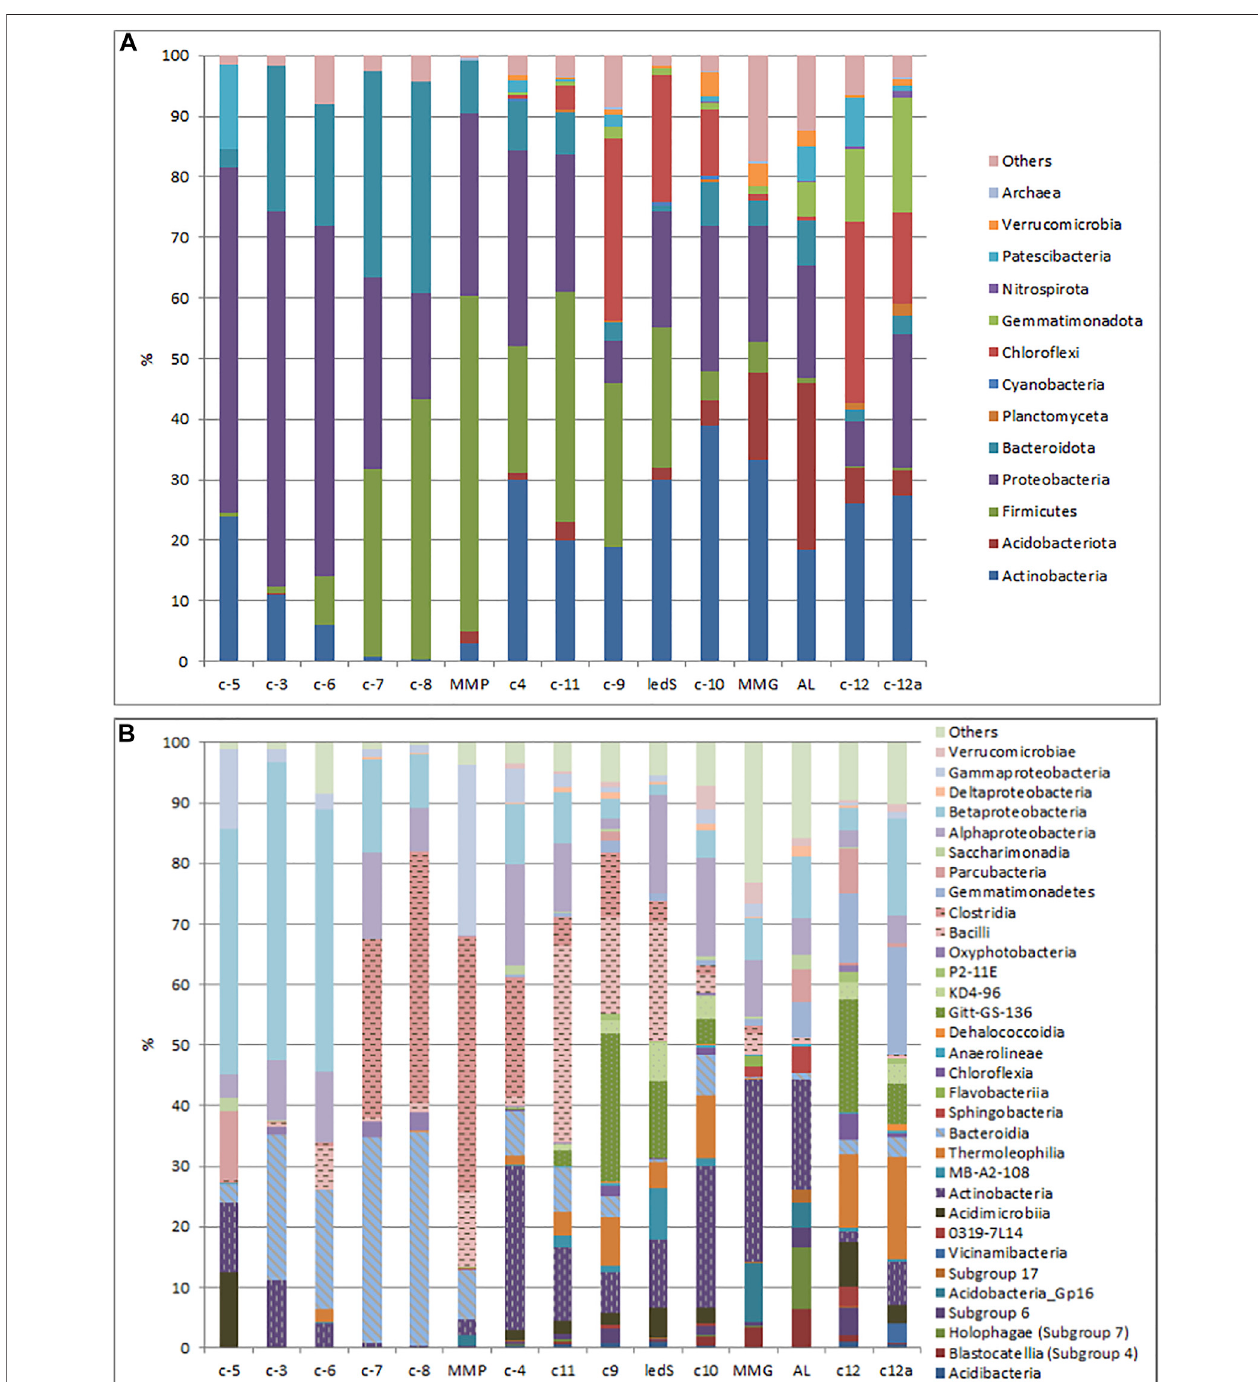
FIGURE9| Relativeabundanceofprokaryoticphyla (A) andclasses (B) indifferenthorizonsofMammothMountainandSyrdakh(thesamplesAL,MMGandMMP correspond to previously studied samples of the ice complex of Mamontova Gora:an active layer (AL), an ice wedge of the upper (MMG) and lower horizons (MMP) (Rakitin et al.,